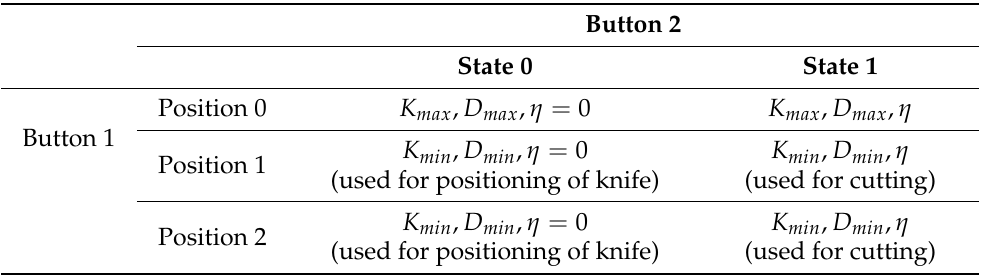
Table 5. Impedance shaping using